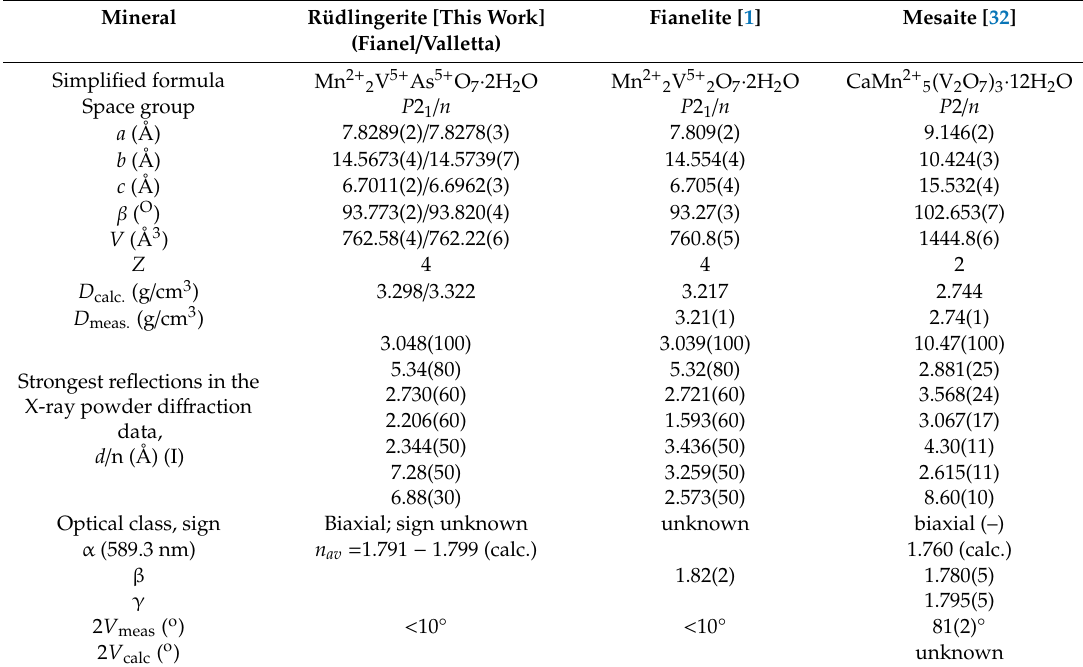
Table 7. Comparison of Rüdlingerite, Fianelite, and